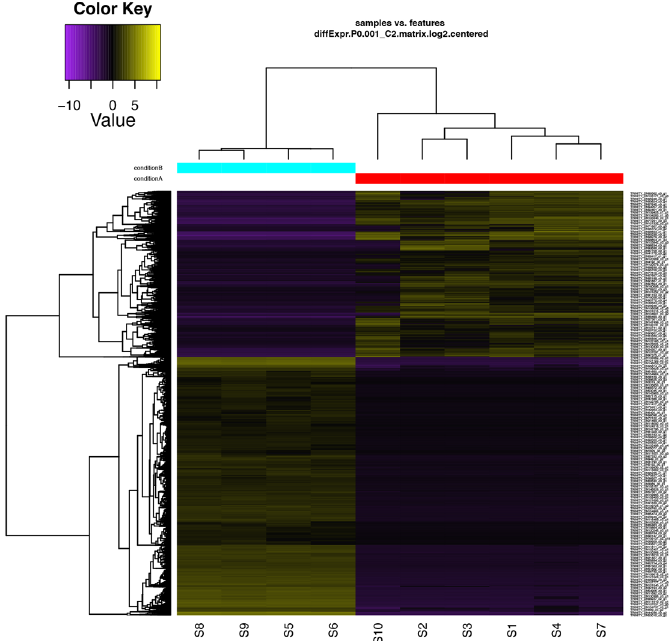
Figure 4. Hierarchical clustering of differentially expressed transcripts of oceanside-riverside R. stylosa leaf samples. Heatmap showing the relative expression levels of each transcript (rows) in each sample (columns). Rows and columns are hierarchically clustered. Expression values (FPKM) are log 2 -transformed and then median-centered by transcript. S1–S4 and S7, S10 are the six replicates from the riverside population and S5, S6, S8, and S9 are the four replicates from the oceanside population. Condition A and Condition B refer to the riverside and the oceanside, respectively.